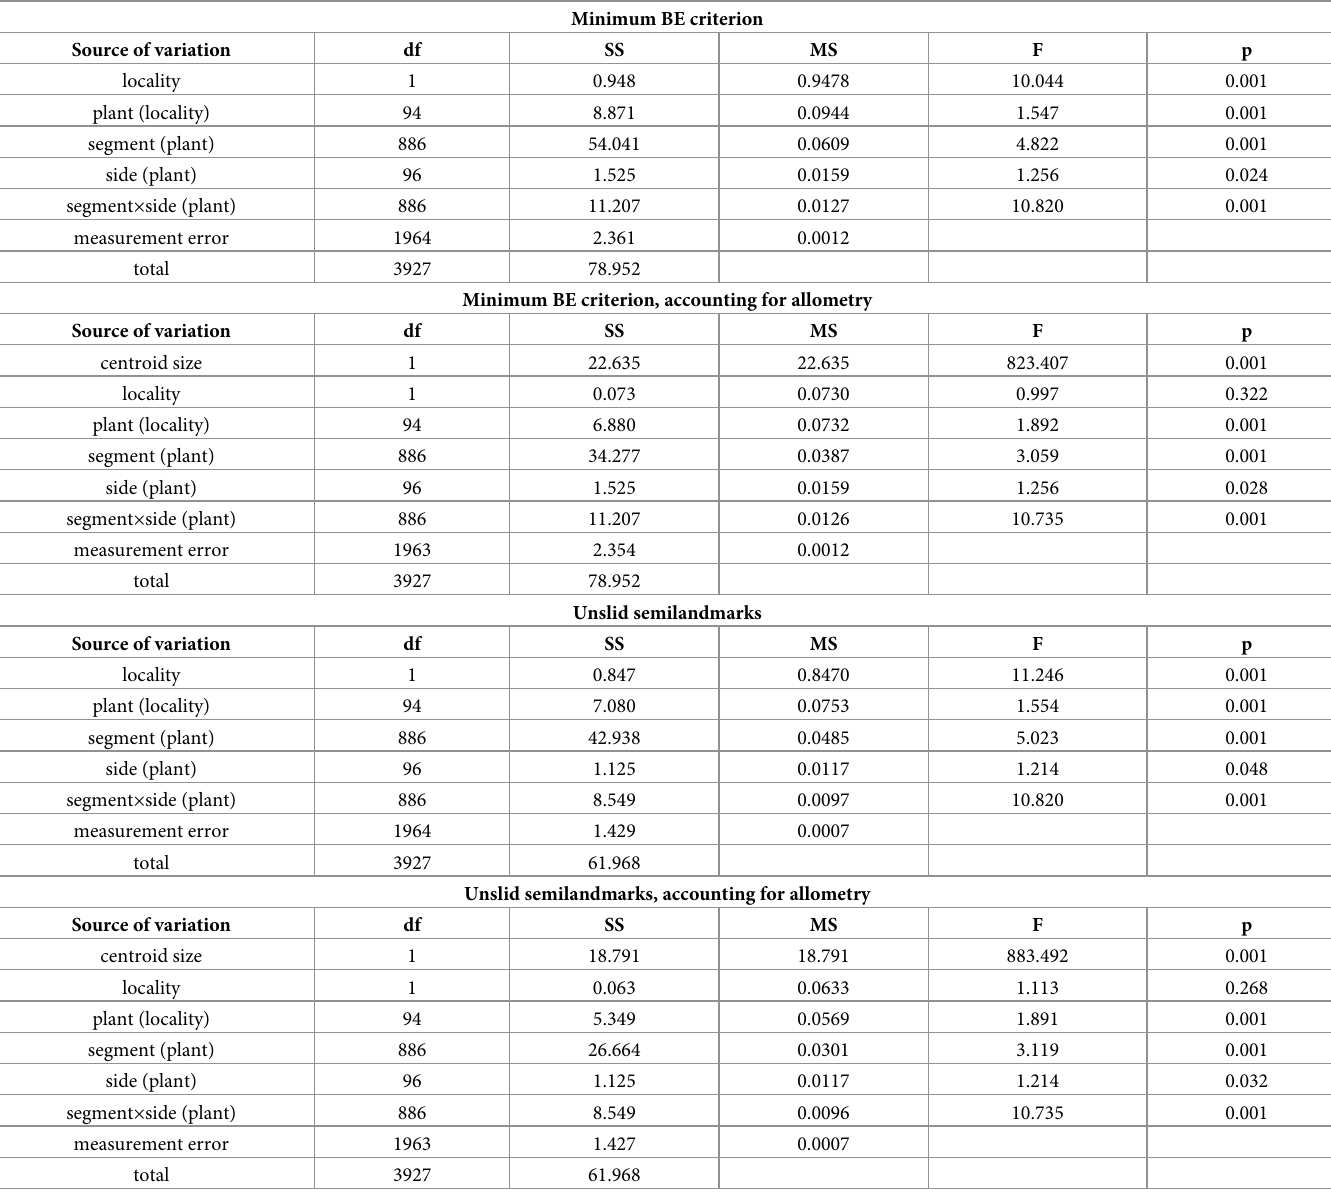
Table 2. Multivariate nested Procrustes ANOVA models for segment shape data. Factor “side” relates to DA and “segment × side” to FA, both nested within the plants. Minimum BE